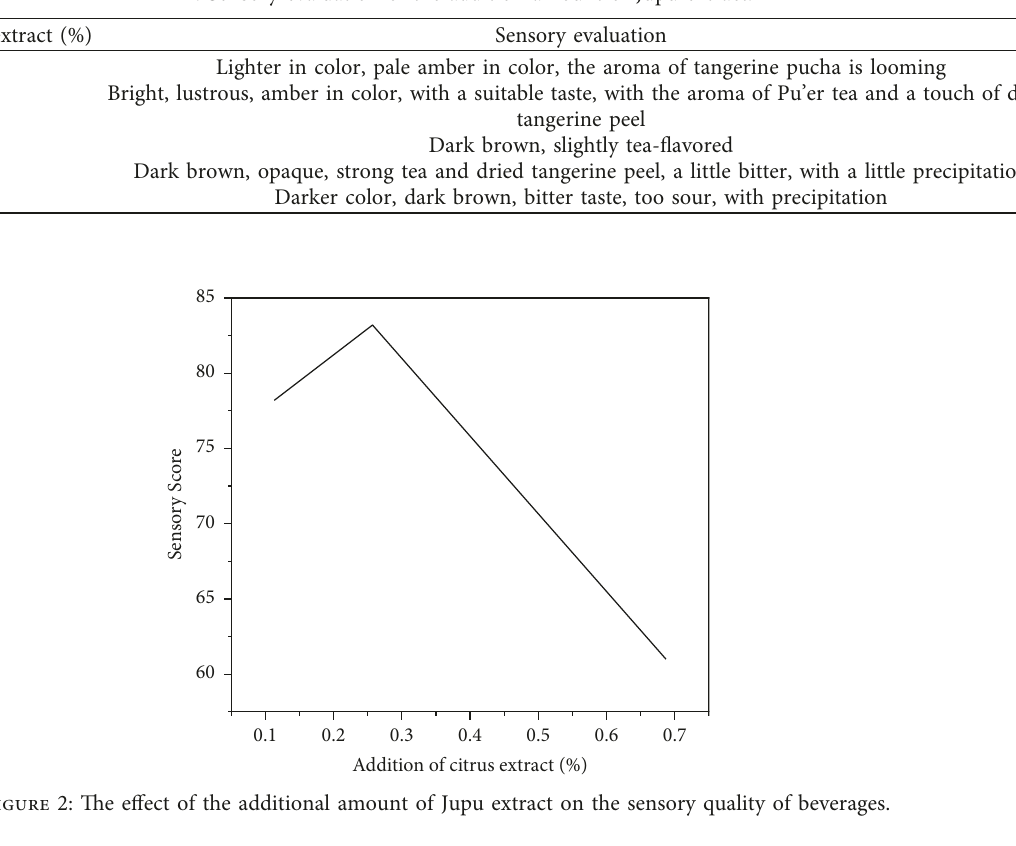
Table 2: Sensory evaluation of the addition amount of Jupu extract.